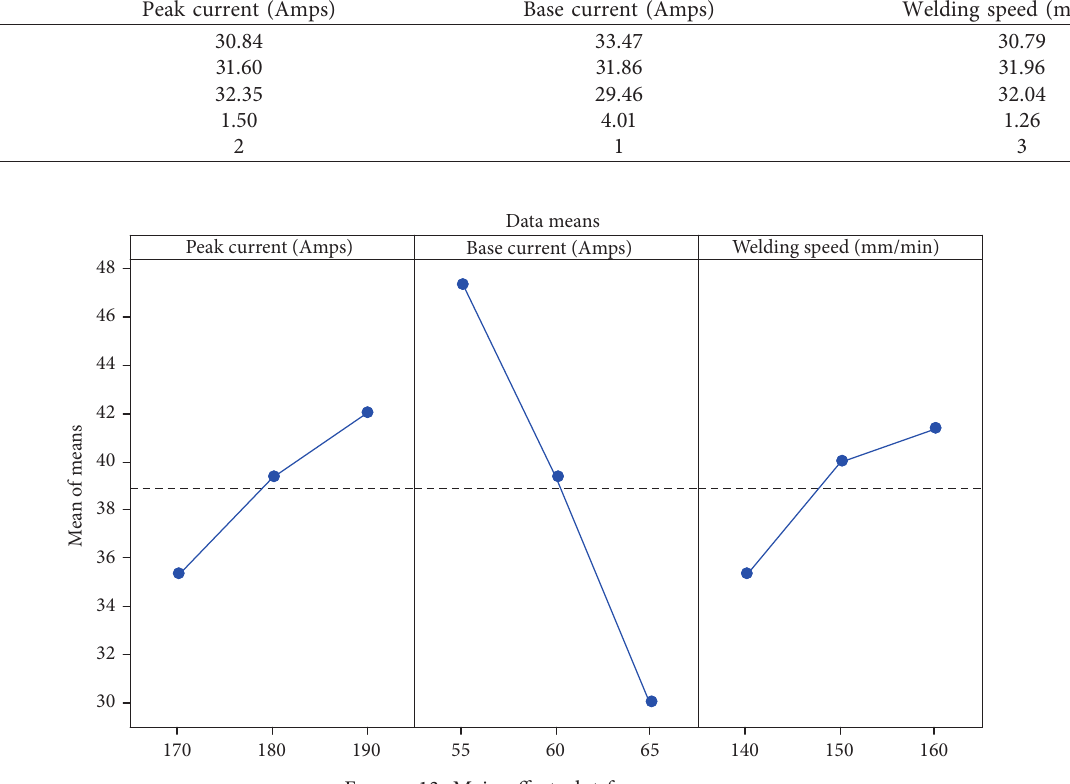
Figure 13: Main effect plot for means.